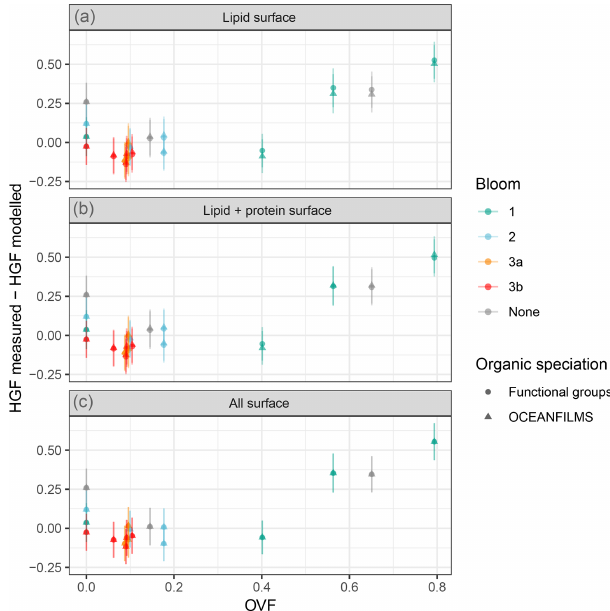
Figure 13. Ambient HGF measured minus compressed-film- modelled HGF for lipids partitioned to the surface (a) , lipids and proteins partitioned to the surface (b) , and all organics partitioned to the surface (c) . Organic speciation derived from FTIR measure- ments (circles) and from OCEANFILMS model